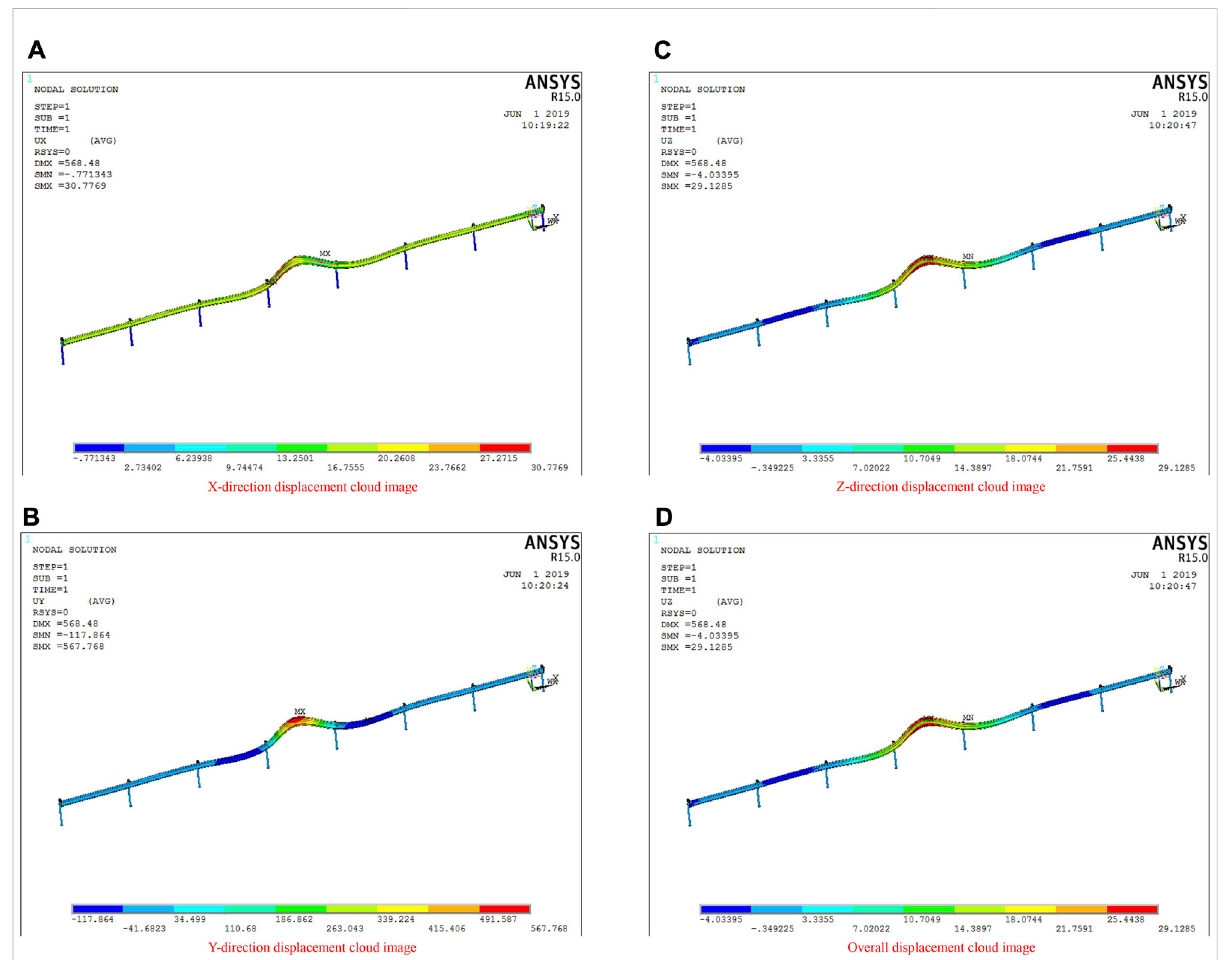
FIGURE 7 Displacementclouddiagramofathree-wavebeamsteelguardrail(impactedbythe40-tHGVatthespeedof65 km/hfromanangleof20 ° ,the concrete-embedded post). (A) : X-direction displacement cloud image of three-wave beam steel guardrail. (B) : Y-direction displacement cloud image of three-wave beam steel guardrail. (C) : Z-direction displacement cloud map of three-wave beam steel guardrail. (D) : Overall displacement cloud image of three-wave beam steel